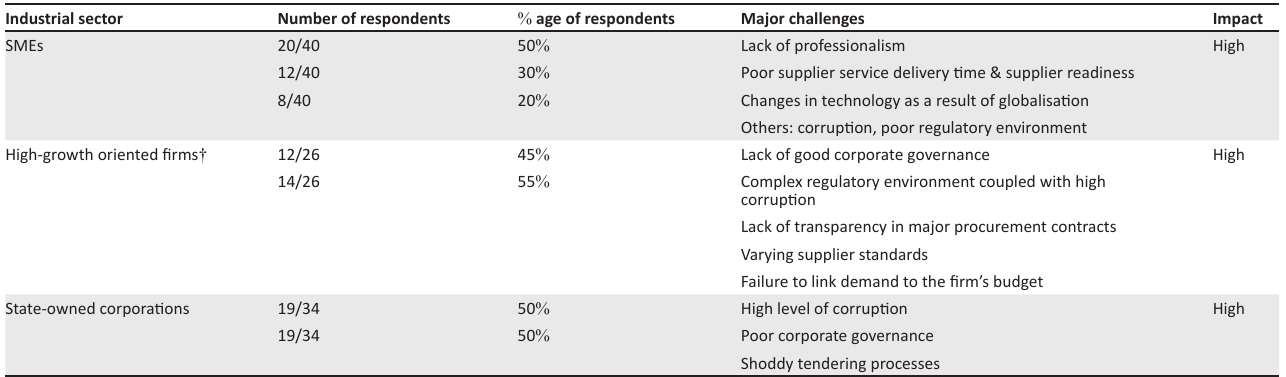
TABLE 2: Common challenges facing procurement in developing economies. Industrial